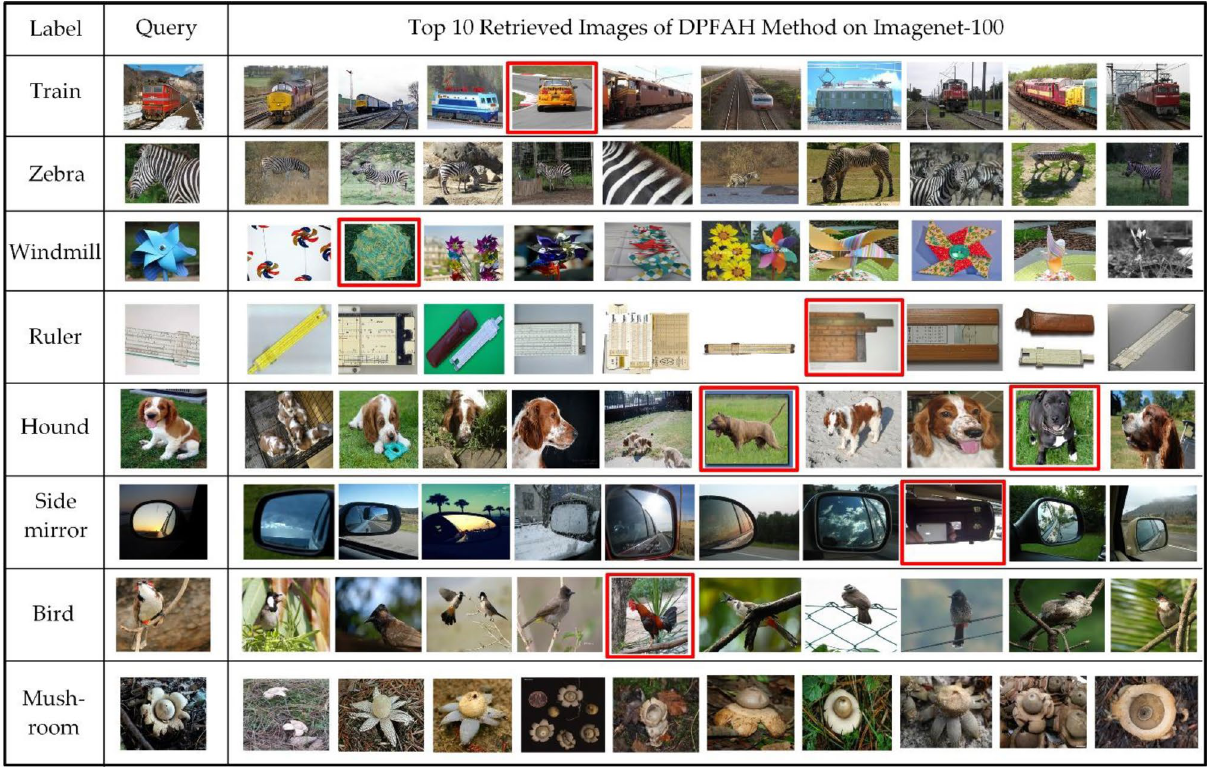
Figure 15. Top 10 retrieved results from Imagenet-100 dataset by DPFAH with 64bit hash codes. (Created by ‘Microsoft Office Visio 2013’ url: https:// www. micro soft. com/ zh- cn/ micro soft- 365/ previ ous- versi ons/ micro soft- visio-